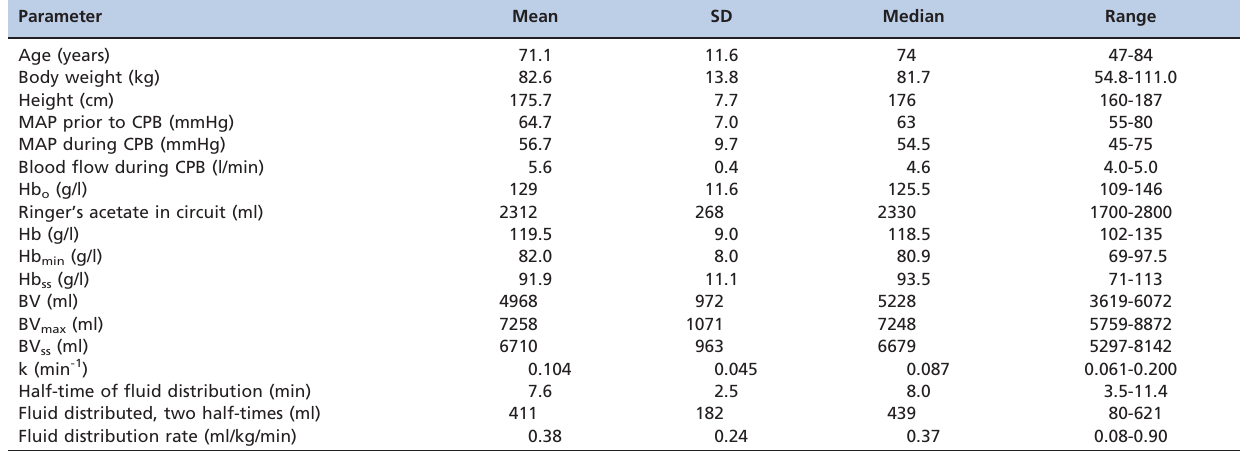
Table 1 - Demographic data, calculation of blood volume by the dilution method and distribution of fluid after connecting 10 patients to an extracorporeal